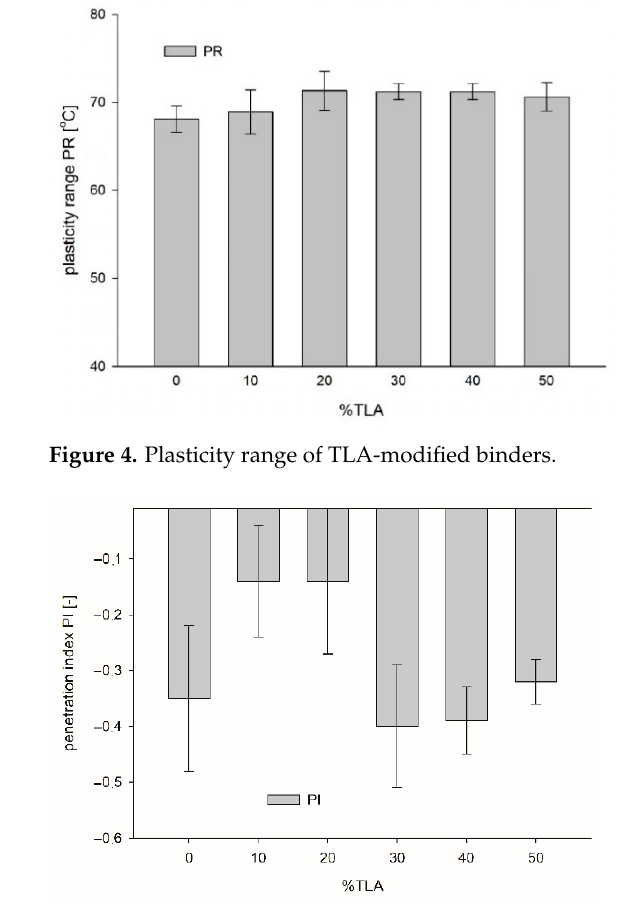
Figure 5. Penetration index of TLA-modified binders.